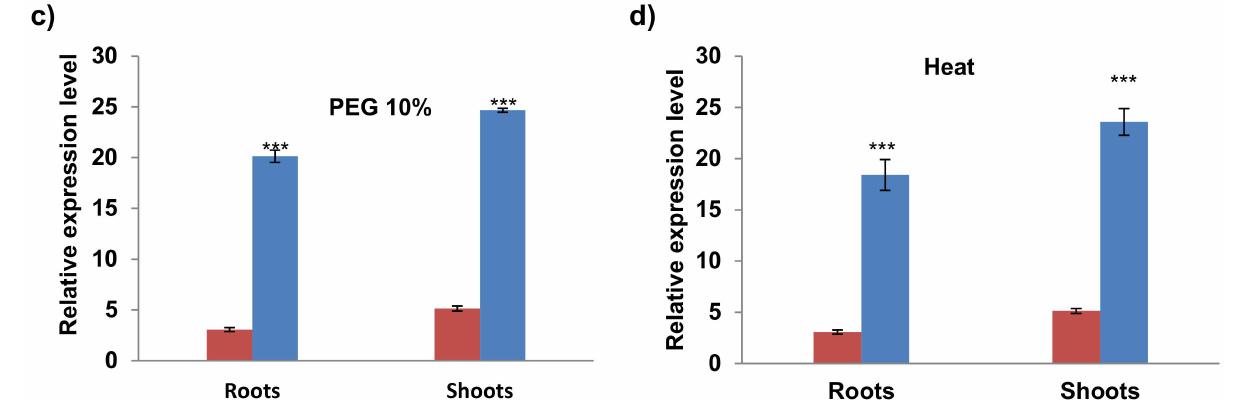
Figure 6. qRT-PCR expression analysis of AvPR-1 gene under different abiotic stresses ( a ) salt, ( b ) mannitol, ( c ) PEG 10%, and ( d ) heat. The red bars represent the expression level of the AvPR-1 gene under standard conditions, and the blue bars represent the expression level of the AvPR-1 gene under stressed conditions. (***) indicates value significantly different from the control. Statistical significance was assessed by applying the student t -test at p < 0.01.